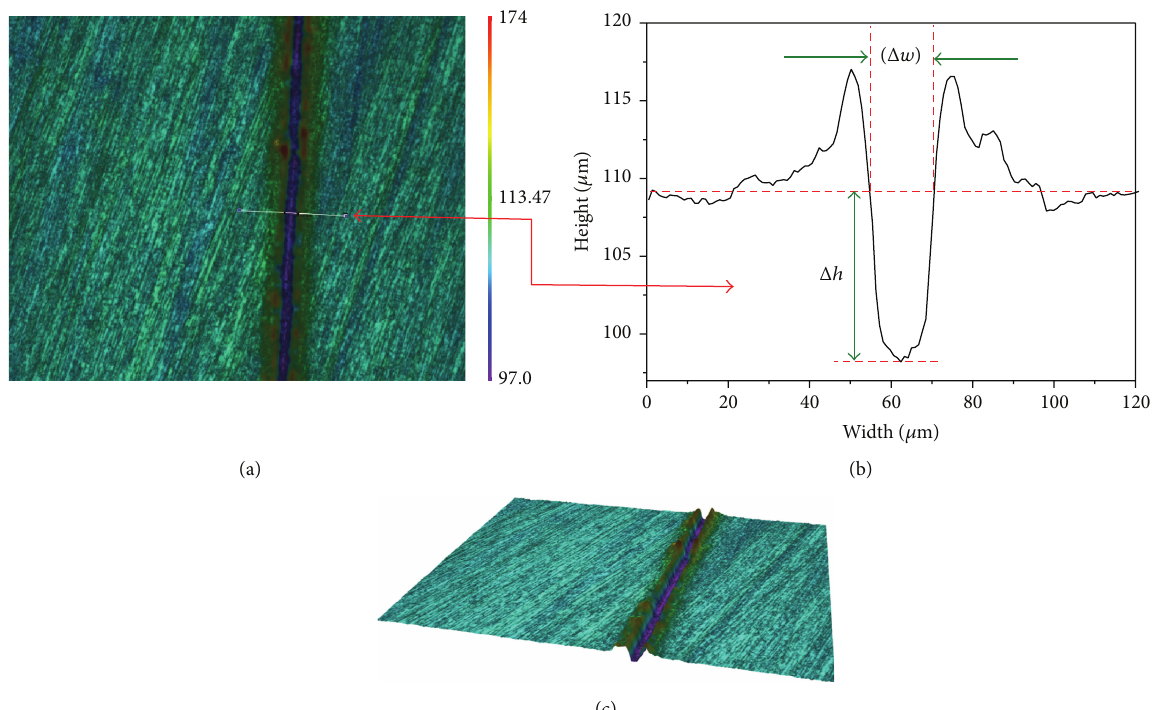
Figure 4: (a) 2D image of the scratch. (b) Width and depth profile through the scratch on the test sample. (c) 3D image of the